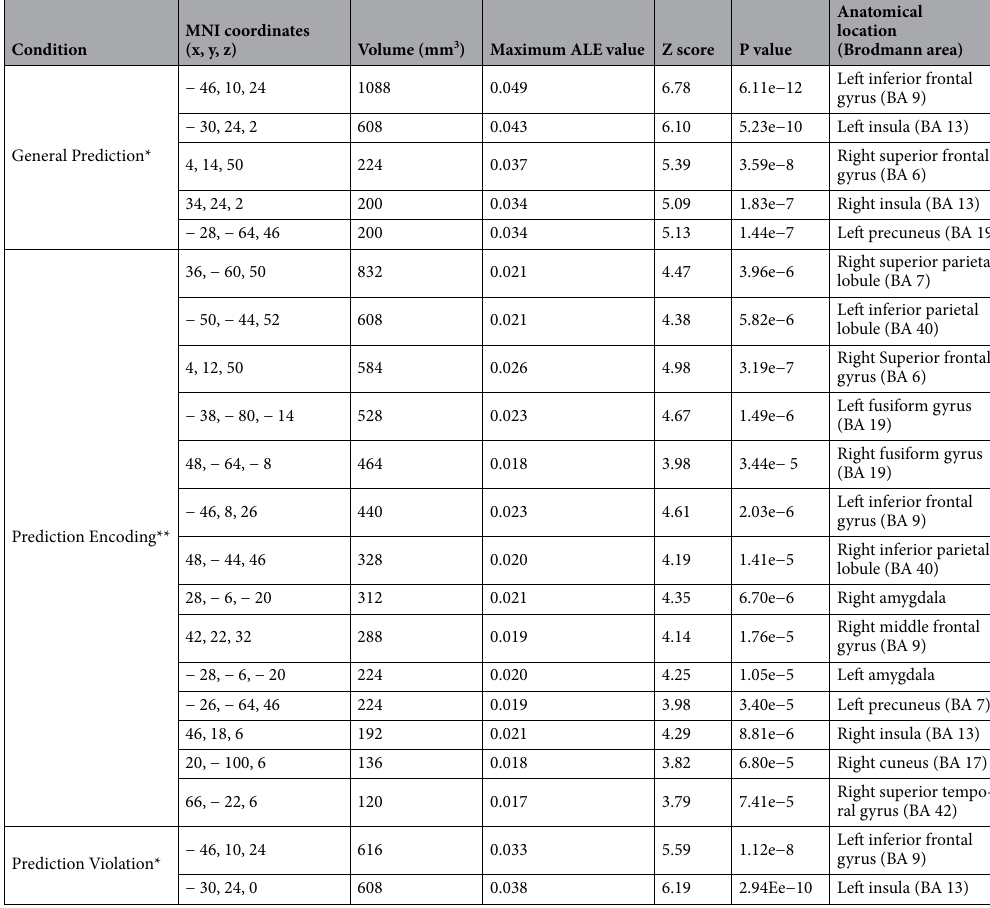
Table 1. Activation likelihood estimation (ALE) results. Convergent findings of brain activity related to predictive coding conditions. *Significant activations are set at voxel-level p < 0.05 with the Family-Wise Error (FWE) correction. **Significant activations are set at p < 0.0005 uncorrected for multiple